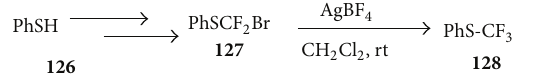
Scheme 30: AgBF 4 -mediated synthesis of trifluoromethyl sulfide.